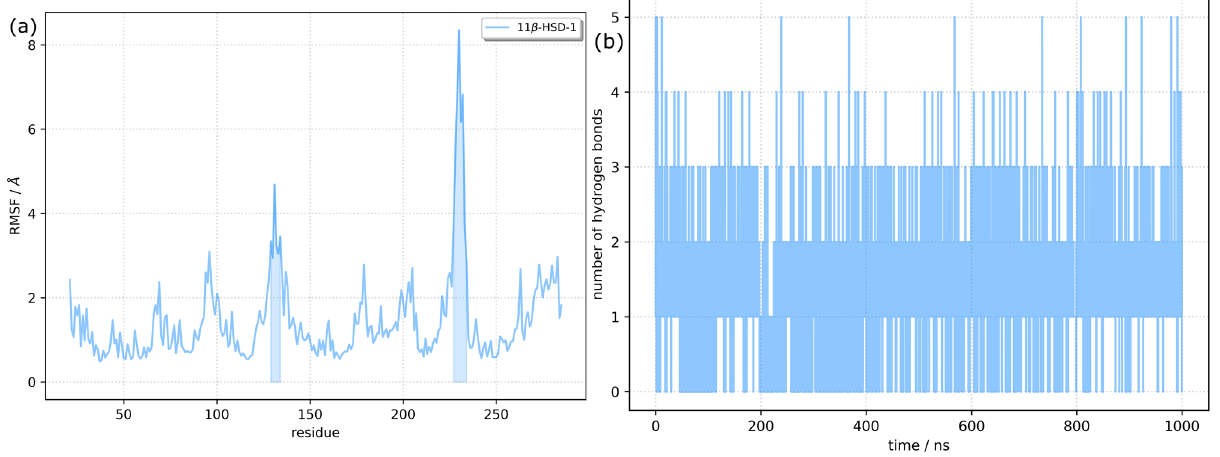
Figure 5. Trajectory analysis. ( a ) Root mean square fluctuations per residue of the RES:11 β -HSD-1 complex. Regions with an RMSF above 3 Å are highlighted; ( b ) Number of hydrogen bond fluctuations.